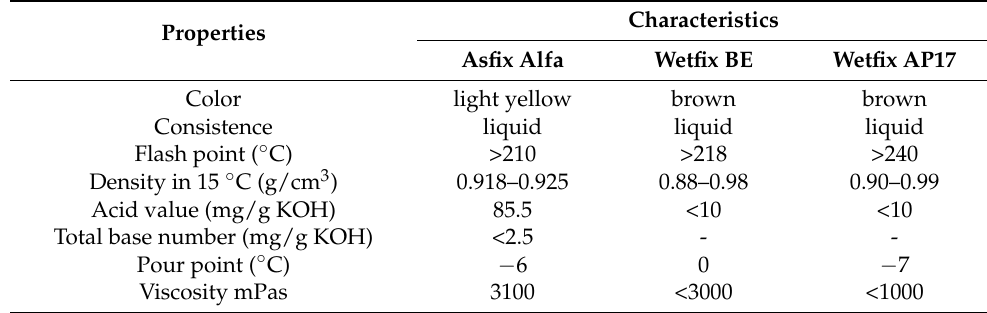
Table 1. The basic properties of various rejuvenators [46,47].